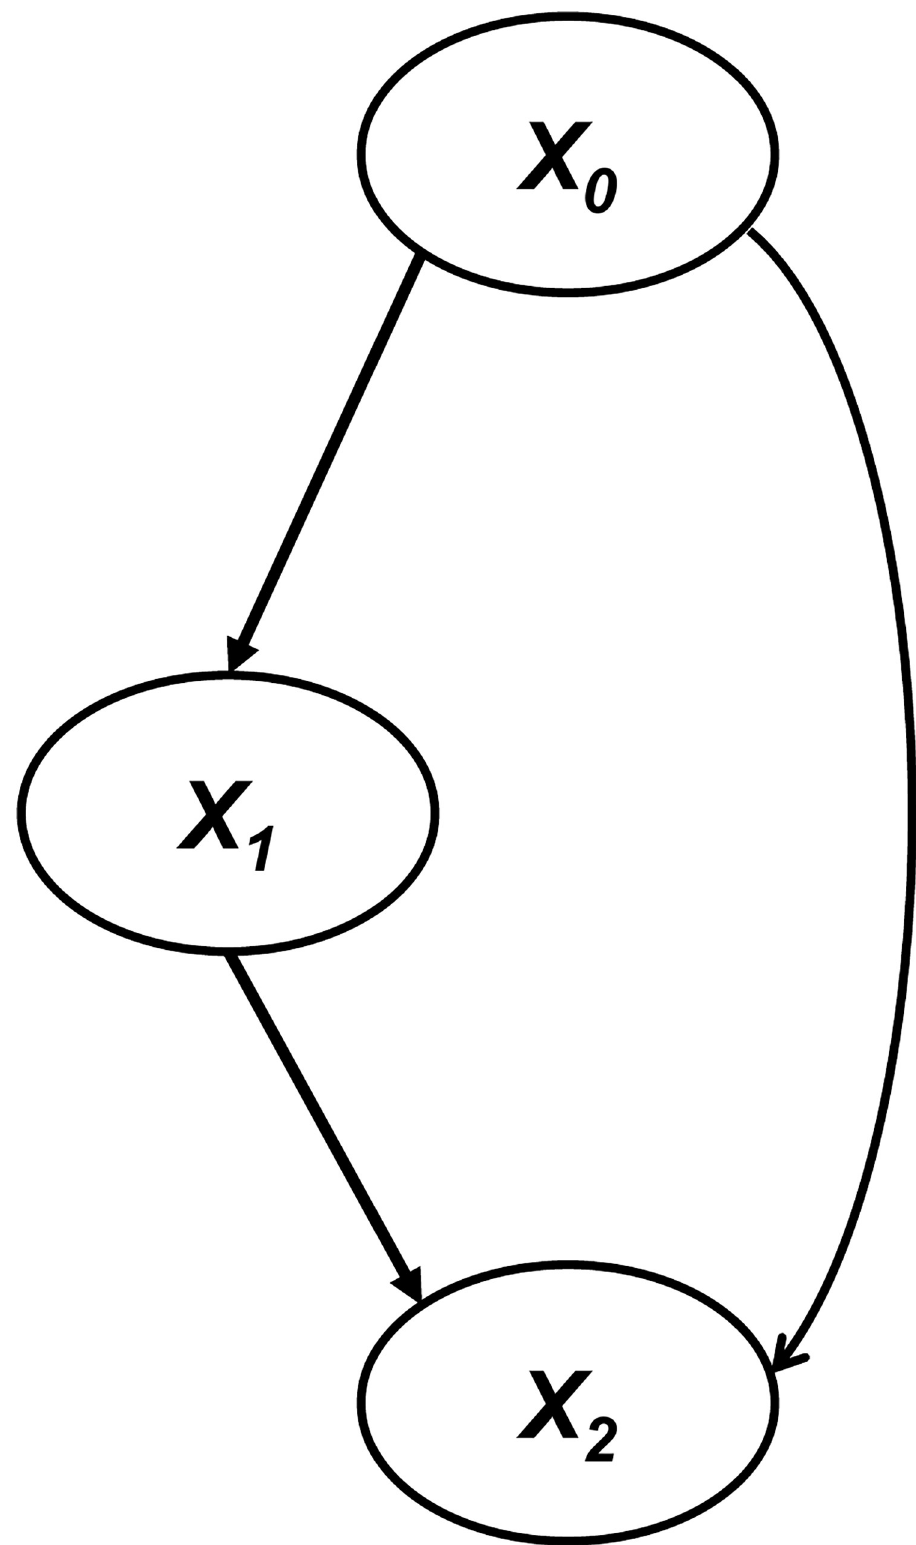
Fig 4. Causal relationship based on the artificial dataset generated from Eq (13). The ellipses represent the variables, and the arrows represent the directions of causality. https://doi.org/10.1371/journal.pone.0283933.g004 PLOS ONE | https://doi.org/10.1371/journal.pone.0283933 April 5,